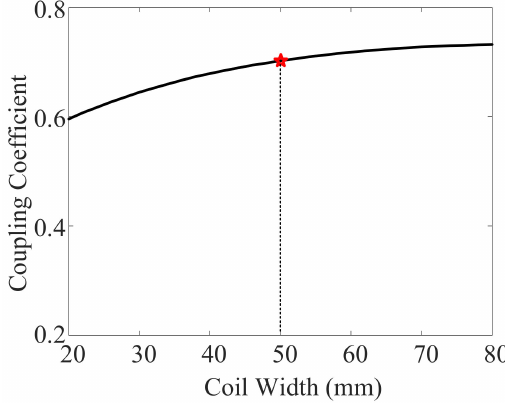
Figure 5. The coupling coefficient varying with the coil